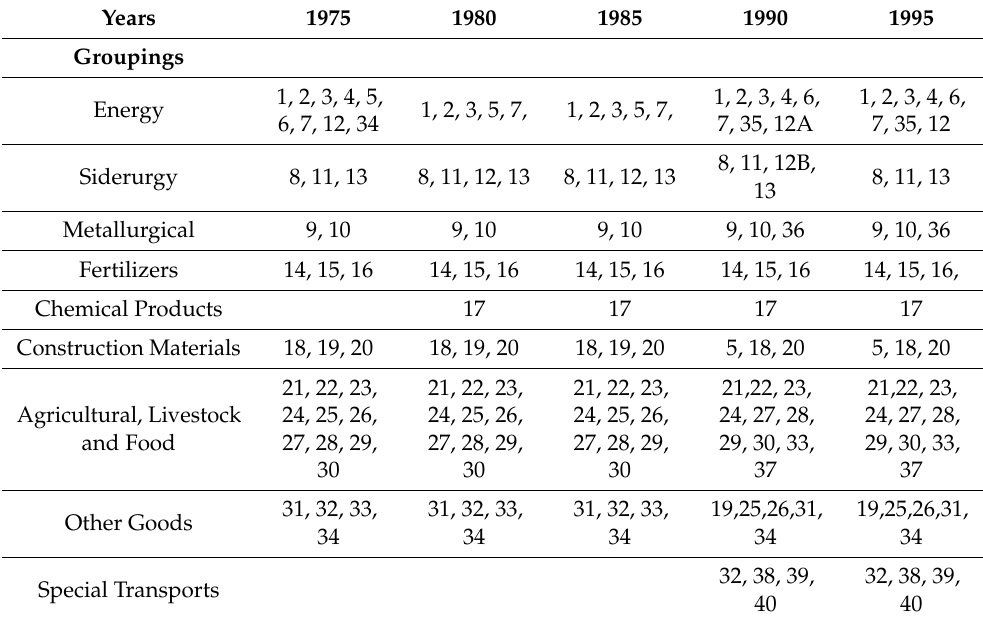
Table 1. Cargo groupings according to their types in state-owned ports in